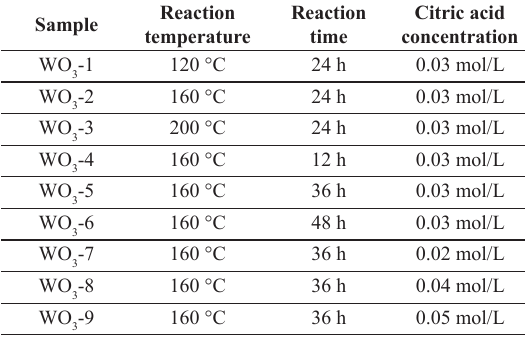
Table 1. Summary of synthesis conditions of WO